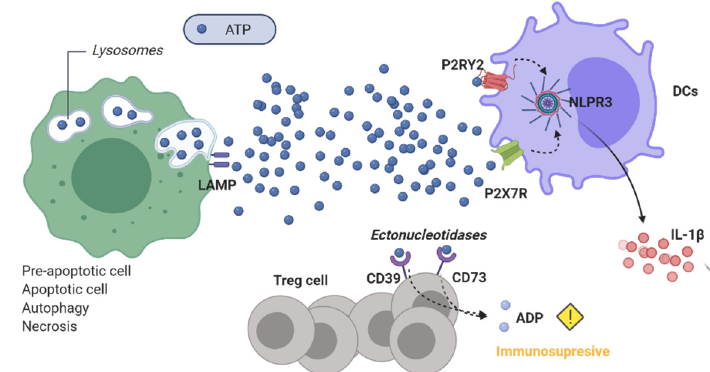
Figure 6. Release and the role played by ATP as a DAMP in TME.